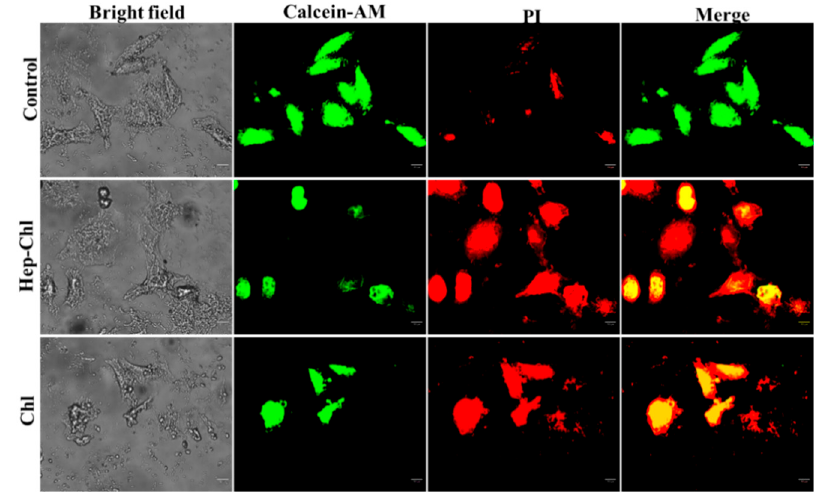
Figure 7. Cell viability. Fluorescence images of the HeLa cells stained with calcein-acetoxymethyl ester (AM)/propidium iodide (PI) with Hep–Chl, Chl, and PBS (control).